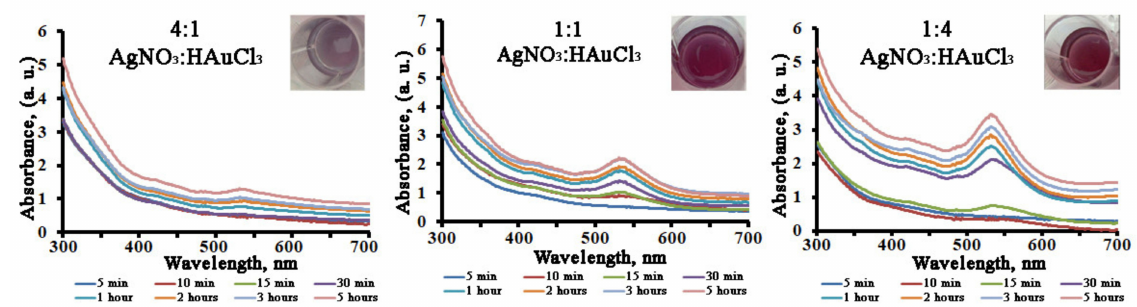
Figure 6. UV-visible spectra of bimetallic Ag/Au NPs synthesized with L . erythrorhizon callus extract as a function of reaction